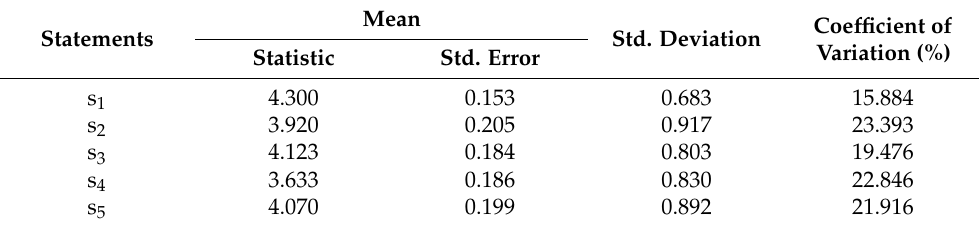
Table 10. Descriptive statistics for a group of customers and suppliers jointly.